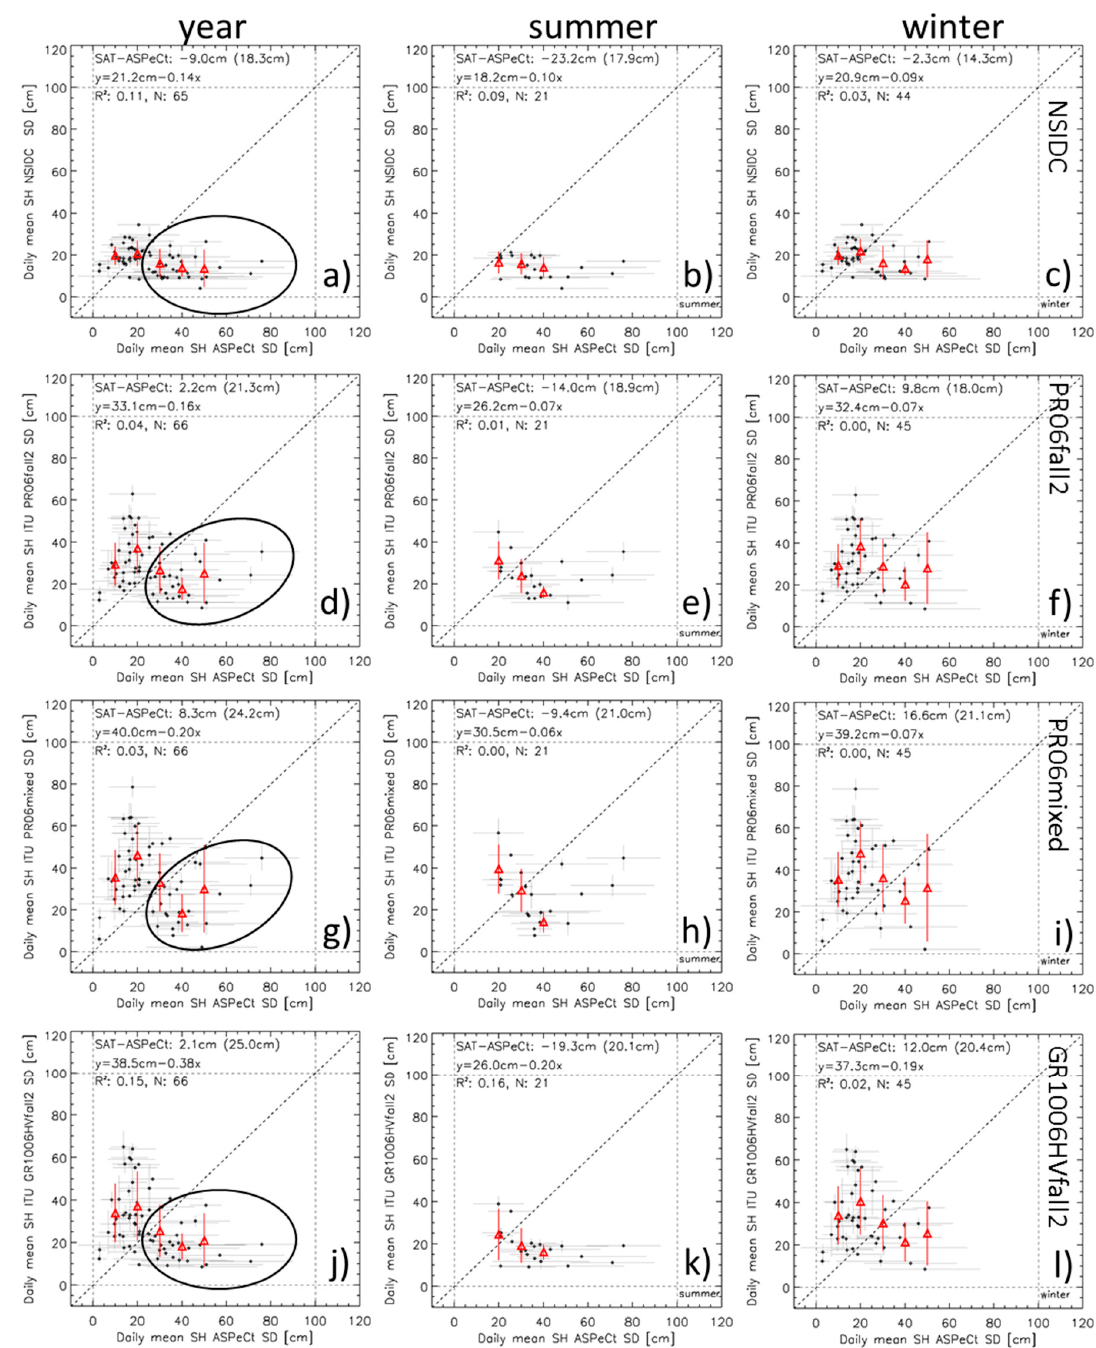
Figure 11. As in Figure 10, but for the AMSR2 snow depths for 2012–2015.